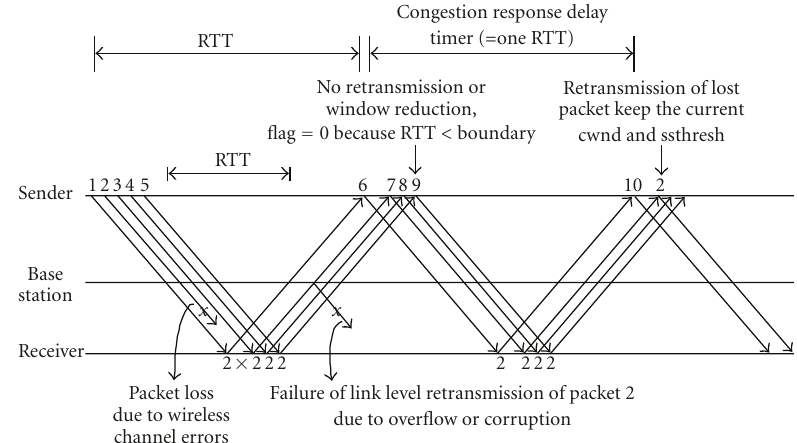
Figure 6: Behavior of the proposed scheme II: a wireless loss.